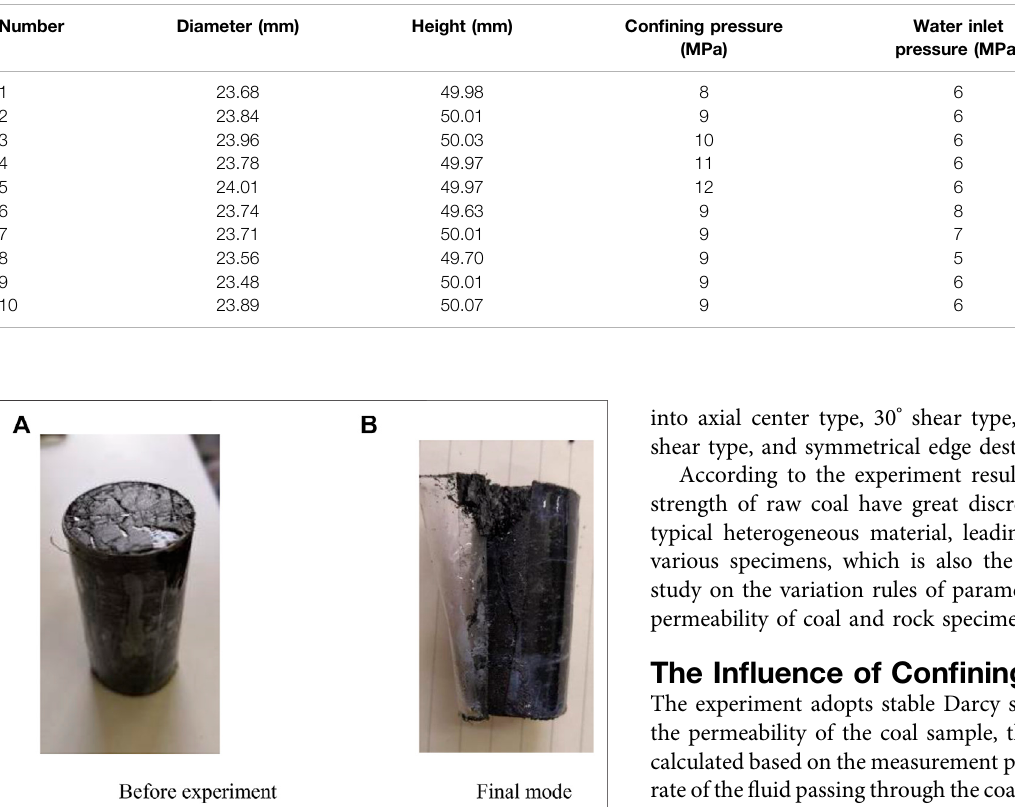
FIGURE 2 | The failure mode of specimen 1. (A) : before experment. (B) : Final mode.